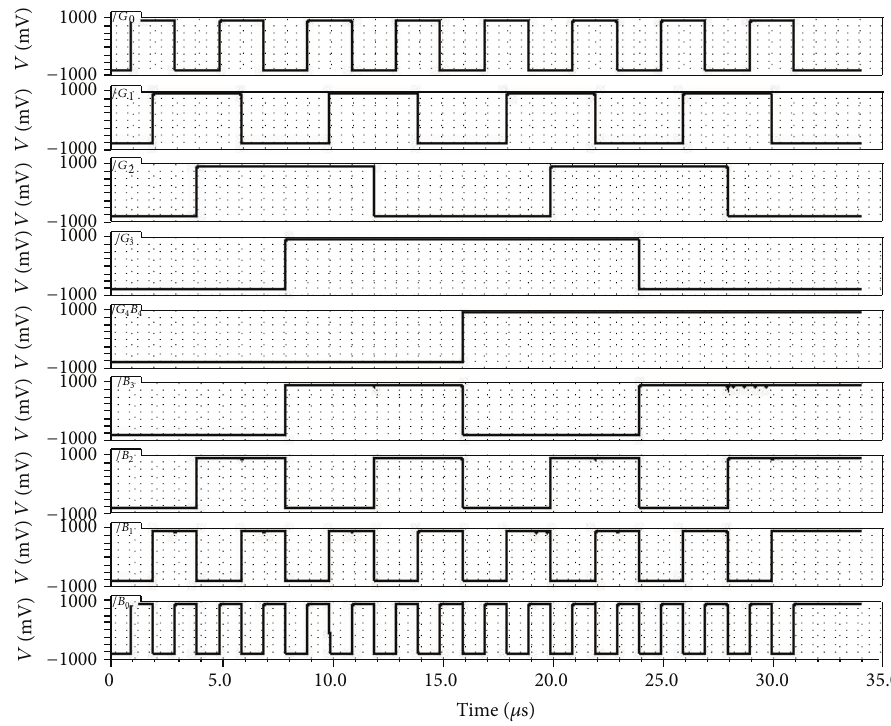
Figure 9: Simulation results of encoder.